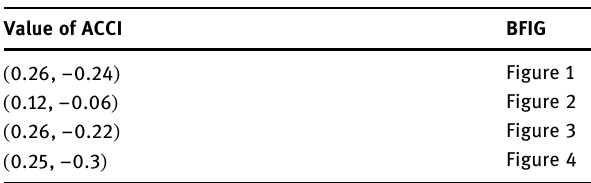
Table 1: The value of ACCI for BFIGs in Figures 1 – 4 Value of ACCI